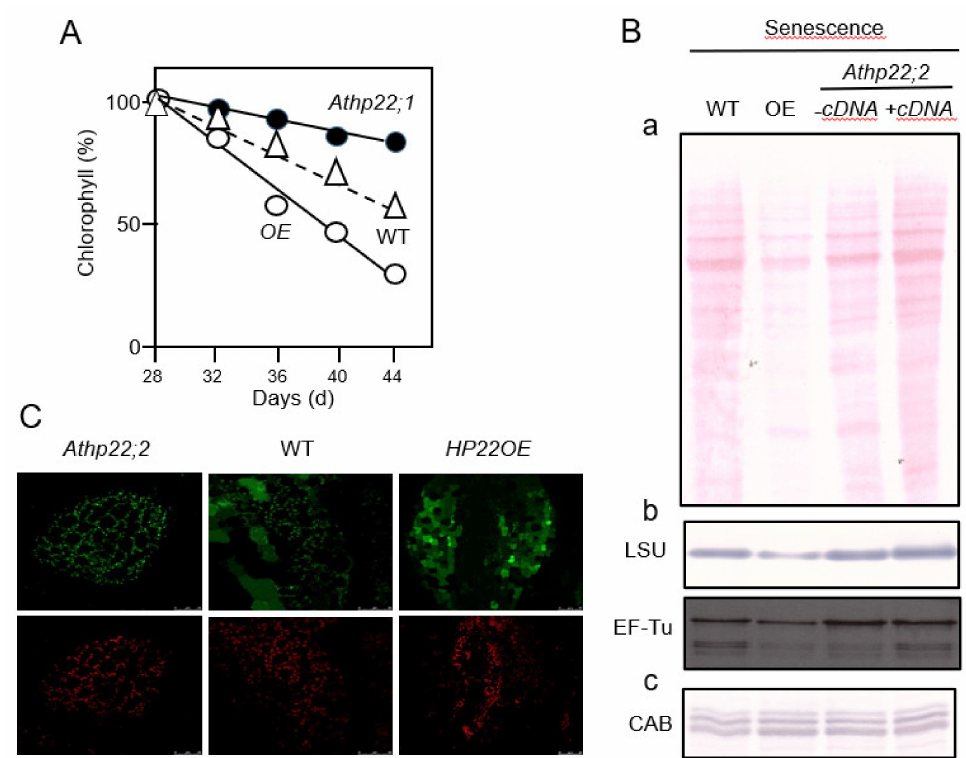
Figure 5. Role of HP22 during leaf senescence. ( A ) Time course of the decay of chlorophyll as a measure of leaf senes- cence progression in wild-type plants (WT), wild-type plants overexpressing the HP22 cDNA (HP22OE), and Athp22;2 (SALK_047513) mutant plants. ( B ) Patterns of Poncau S-stained total chloroplast proteins ( a ) and respective Western blot analysis ( b ) on 5 weeks-old wild-type plants (WT), wild-type plants overexpressing the HP22 cDNA (OE), as compared with Athp22;2 (SALK_047513) mutant plants ( − cDNA), and genetically complemented Athp22;2 (SALK_047513) plants (+ cDNA). Replicate protein gel blots were proved with antibodies ( b and c ) against plastid-encoded soluble stromal proteins, such as the large subunit of ribulose-1,5-bisphosphate carboxylase/oxygenase (LSU) and elongation factor EF-Tu ( b ), and nucleus-encoded thylakoid membrane proteins such as the light harvesting proteins of photosystem II (CAB)( c ). Note that all protein data refer to on an equal plastid number basis. ( C ) Senescence-induced leakage of stromal GFP from chloroplasts in planta . Sl-pRC32 (rrn16::accD*)-driven GFP accumulation in chloroplasts was allowed to proceed in leaves of transplastomic Athp22;2 (SALK_047513), wild-type plants and HP22OE plants. Chlorophyll and GFP fluorescence was collected simultaneously by confocal laser scanning microscopy and compared for the different genotypes. Note the beginning leakage of GFP from chloroplasts in 5 weeks-old wild-type plants that is indicative of senescence progression, the lack of a comparable GFP leakage from chloroplasts in the Athp22;2 (SALK_047513) mutant, and the acceleration of GFP leakage from chloroplasts in wild-type plants overexpressing HP22. Original scale bars are